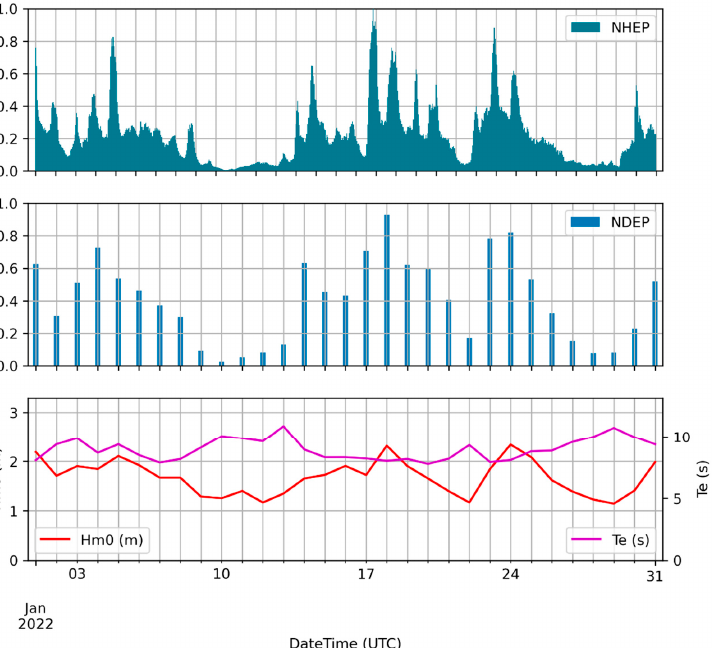
Figure 11. Upper and middle panel: nondimensionalized hourly and daily energy produced in January 2022, respectively. Lower panel: daily wave height Hm0 and energy period Te obtained from the WW3 hindcast for the same period.